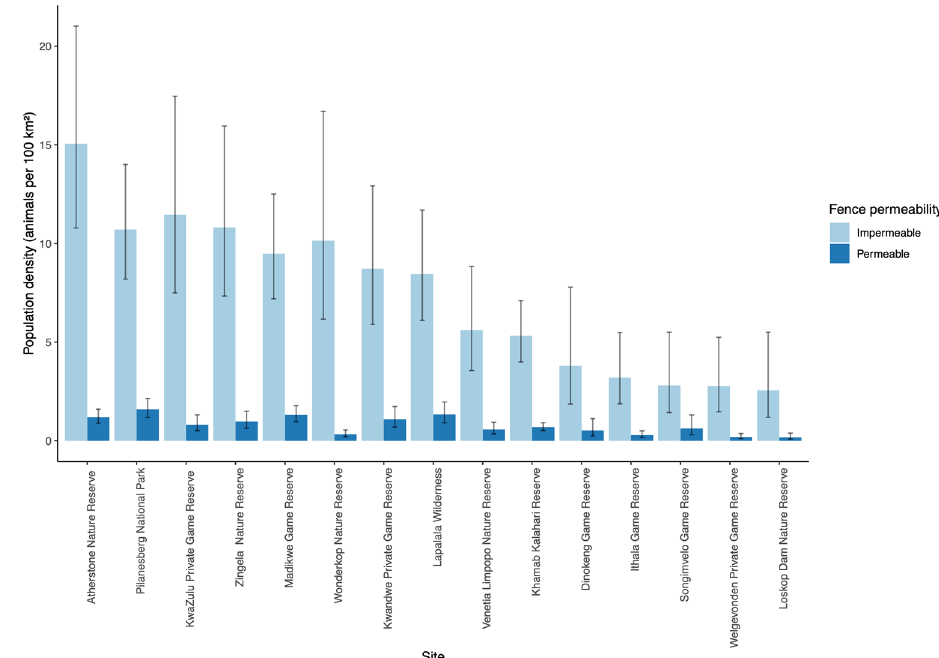
Figure 2. Population density estimates for brown hyaenas as each site assuming that fences were either permeable or impermeable to hyaena movement. Error bars show 95% confidence intervals.